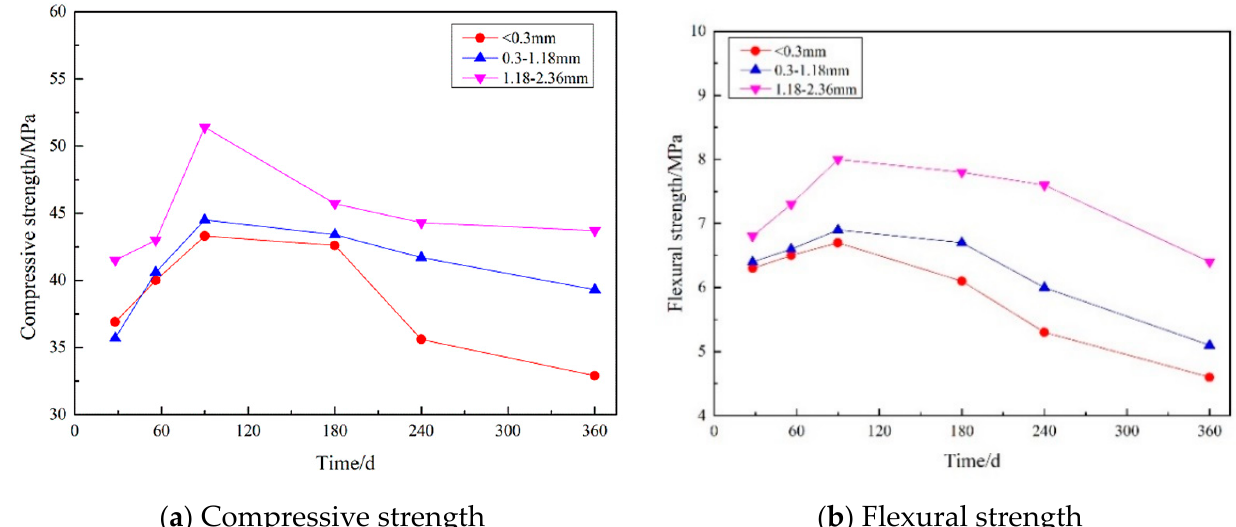
Figure 16. Strength of mortars with different sizes of gypsum aggregate.